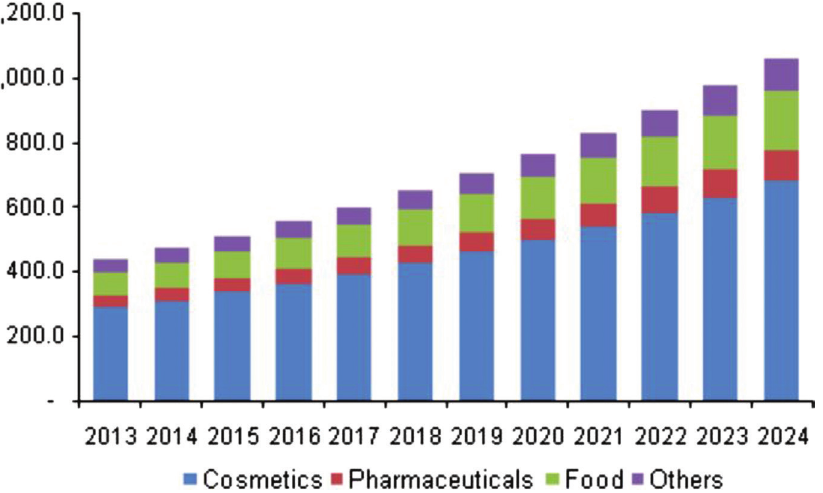
Figure 1: US squalene market by application in tons (from